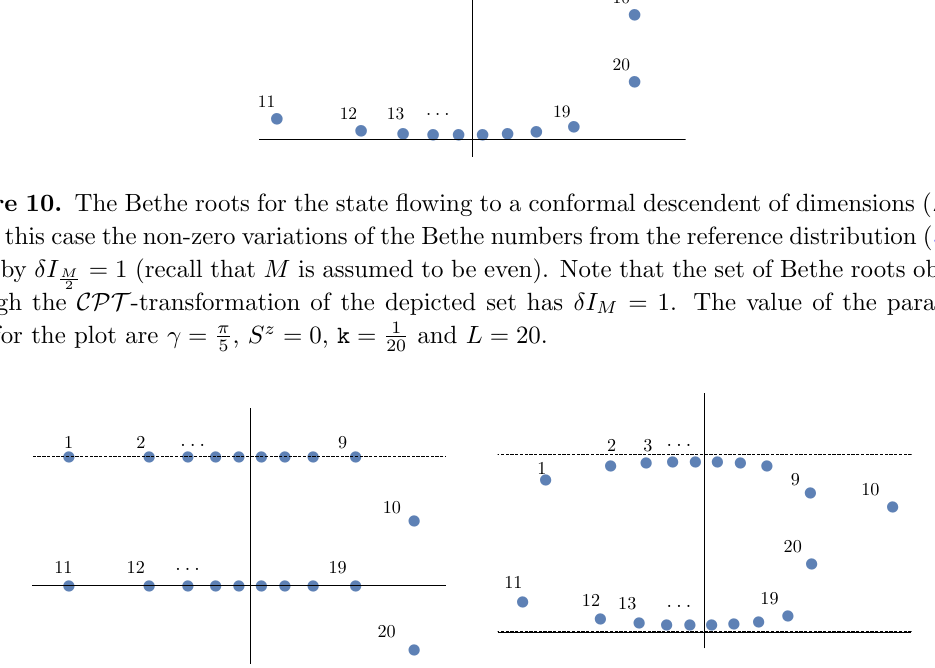
Figure 11. The pattern of Bethe roots for the states (cid:13)owing to the conformal descendent with ( (cid:22)(cid:1) ; (cid:1)+2). The left panel corresponds to the CPT -invariant state whose non-vanishing (cid:14)I j are given by (cid:14)I M = (cid:14)I M = 1. For the state corresponding to the right panel, one has (cid:14)I M 2 The Bethe roots for the other three states of this type are obtained by the CPT (11) and D (12) transformations. The non-vanishing (cid:14)I j for these three states are (cid:14)I M (cid:0) 1 = (cid:14)I M = 1 ( D -transformed state) (cid:14)I M = 2 ( CPT -transformed state) and (cid:14)I M The values of the parameters used in the plot are (cid:13) = (cid:25)